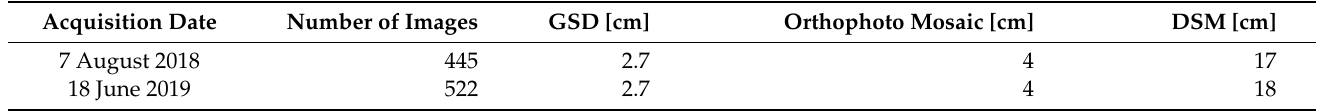
Table 1. Acquisition date, number of images and ground sampling distance (GSD) of drone imagery, and spatial resolution of photogrammetry